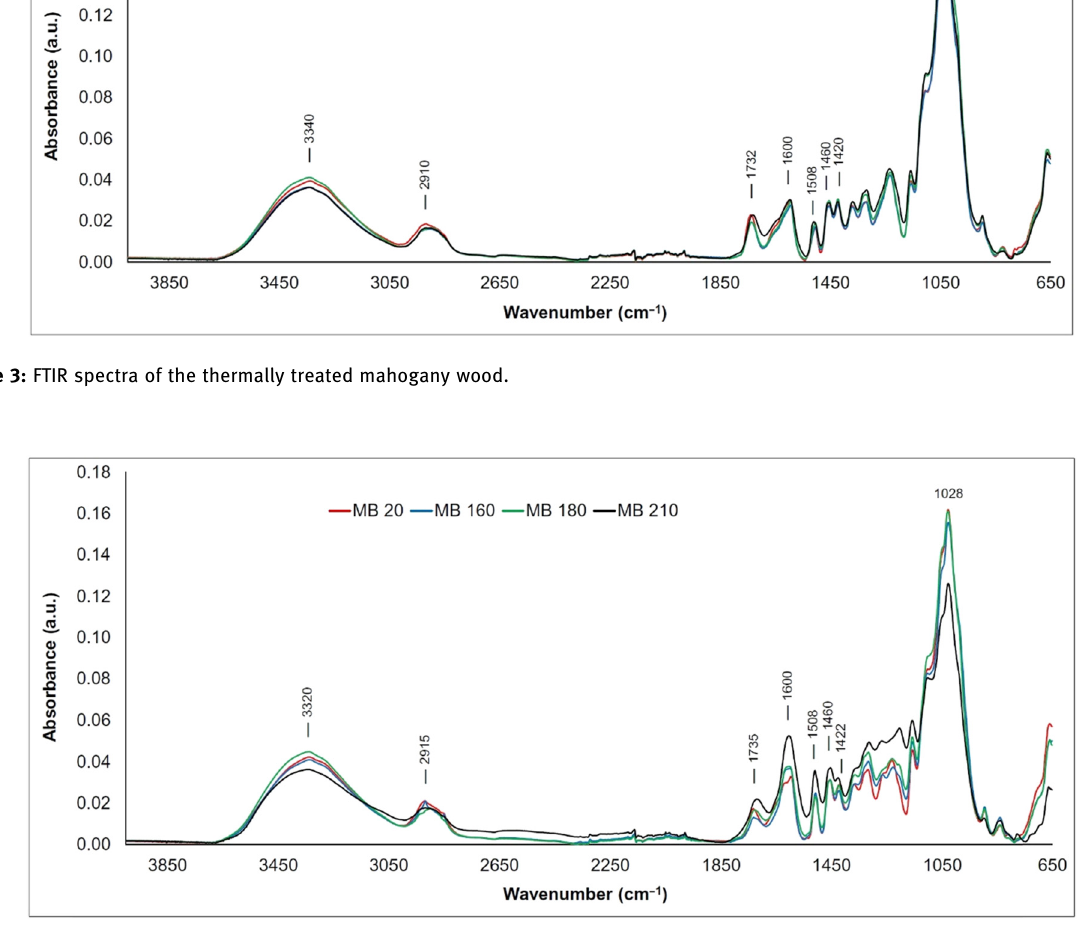
Figure 4: FTIR spectra of the thermally treated merbau